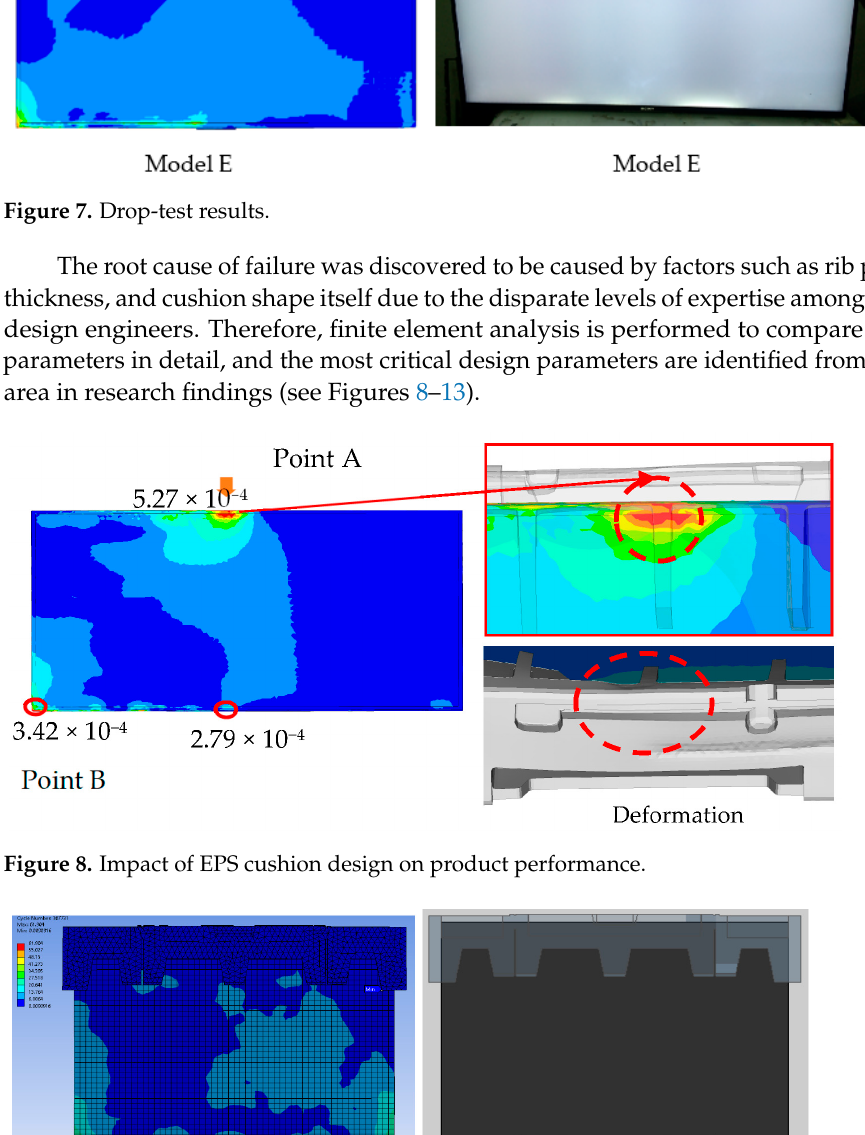
Table 4. Material properties for analysis. Figure 6. Drop test result.